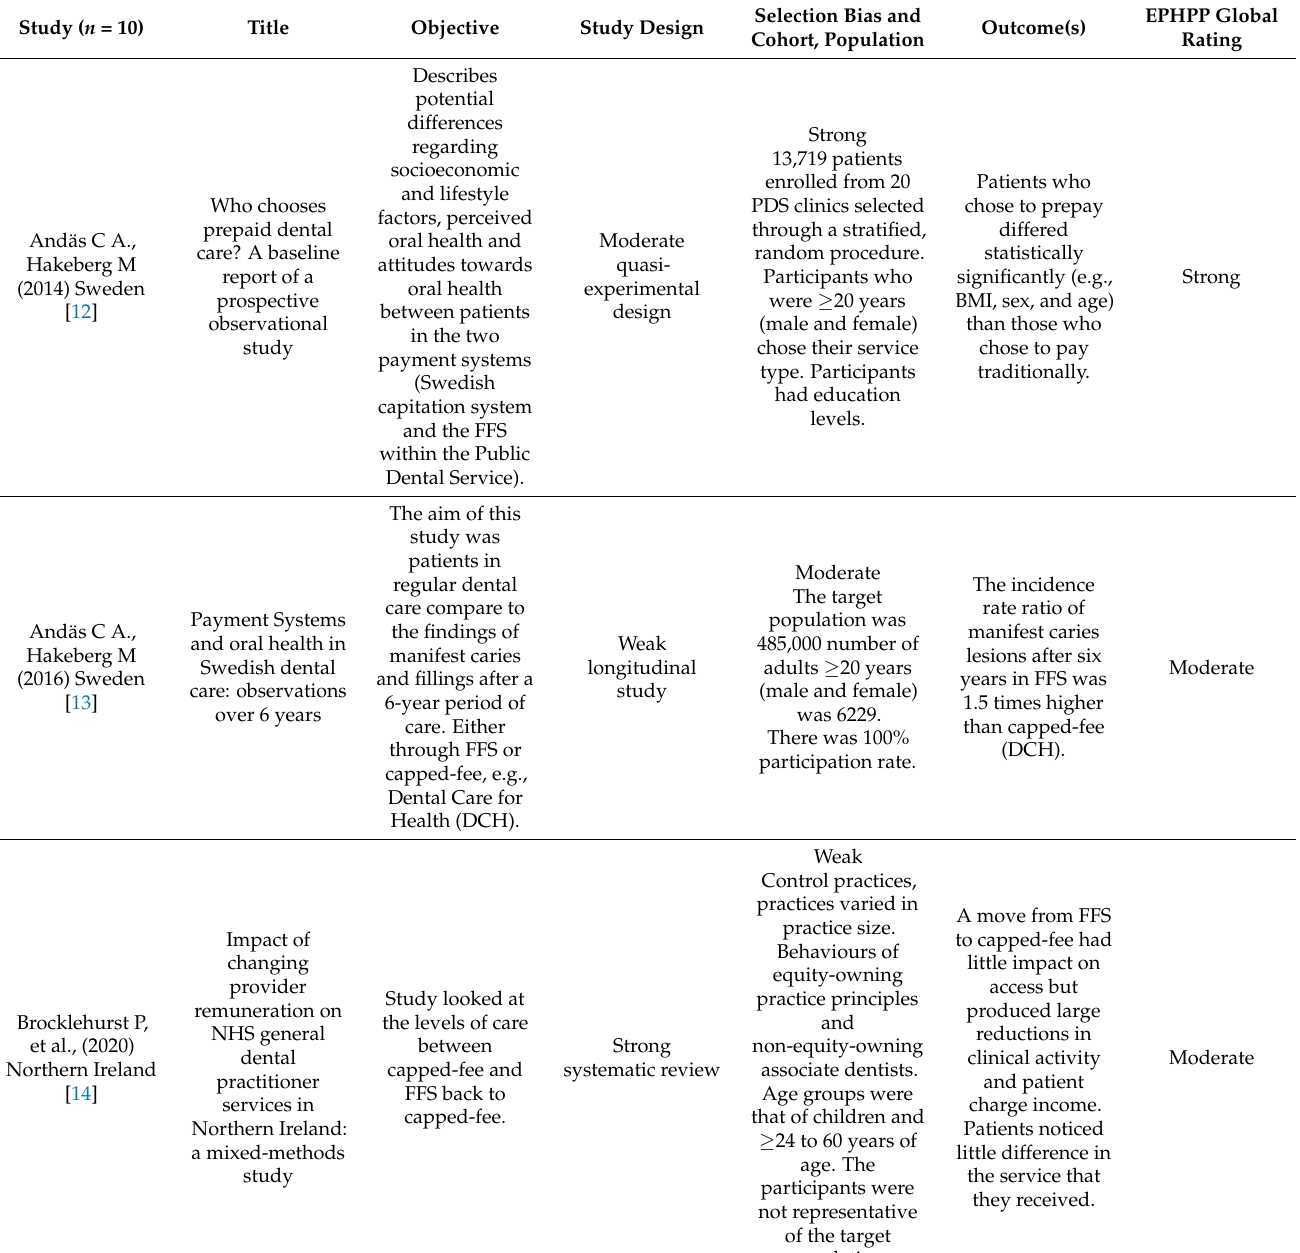
Table 1. Summary of selected